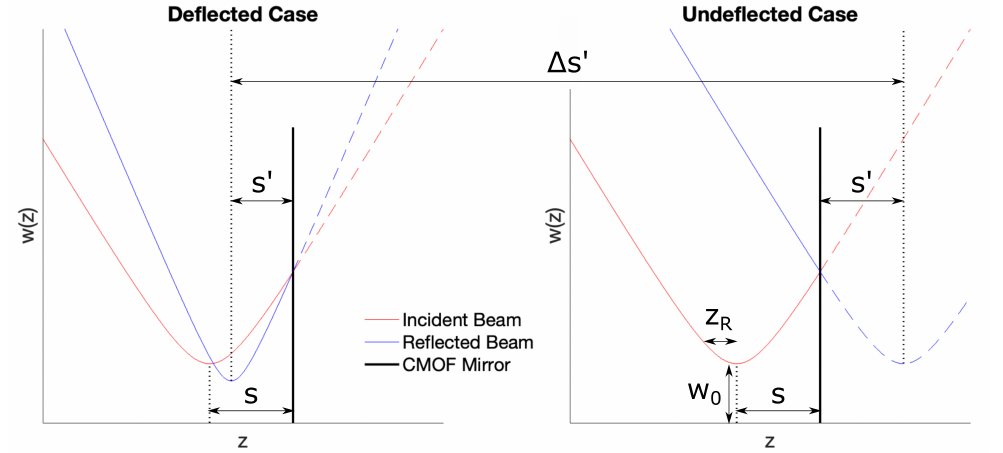
Figure 4. Outline of incident and reflected beam parameters for refocusing of a Gaussian beam by a CMOF membrane. Beam waist simulations for a 30 µ m membrane, a 532 nm beam, and a maximum membrane deflection of 150 nm. The plot shows incident and reflected beams, the mirror surface, and the position of the refocusing.